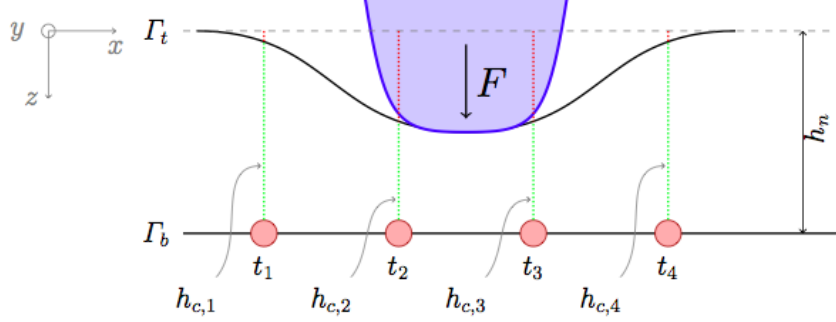
Figure 1. An ideal cross-section of ROBOSKIN in a contact event: The top layer is deformed by a pressure distribution, which is measured by taxels t i